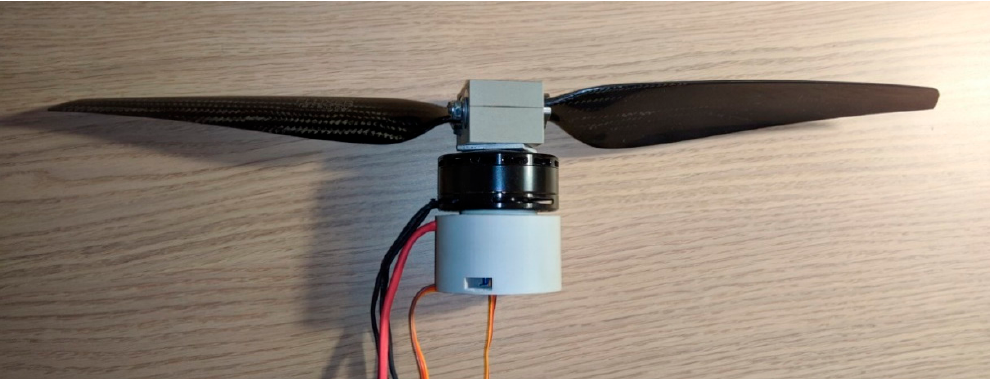
Figure 4. Variable pitch propeller with the engine.